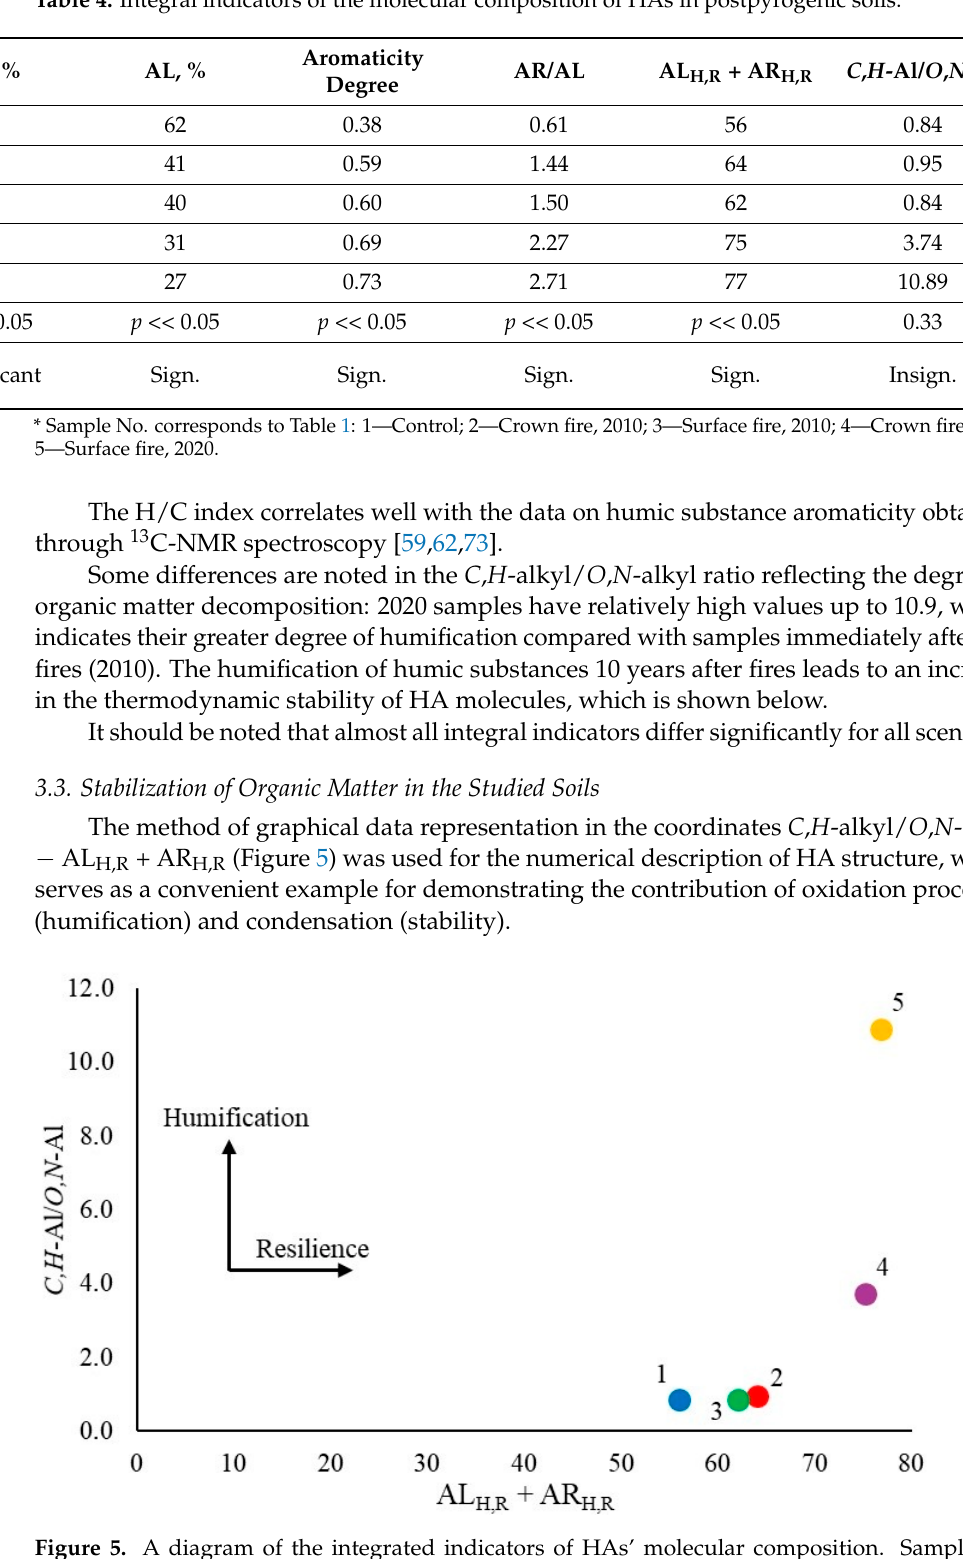
Figure 5. A diagram of the integrated indicators of HAs’ molecular composition. Sample No. corresponds to Table 1: 1—Control; 2—Crown fire, 2010; 3—Surface fire, 2010; 4—Crown fire, 2020; 5— Surface fire, 2020.